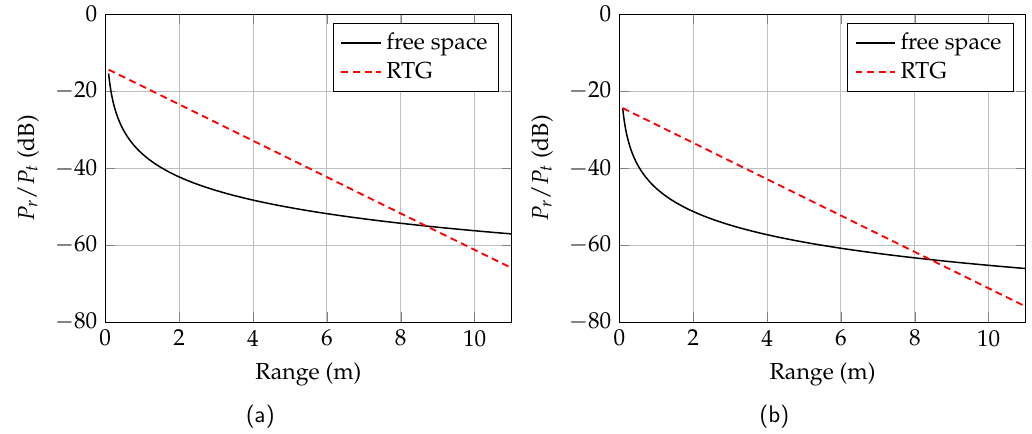
Figure 10. Power ratio P r / P t for a radar with free-space propagation and the RTG. The ratio is simulated for water ( a ) and palm oil ( b ). Table 1. Link-budget parameter for free-space propagation and the RTG.